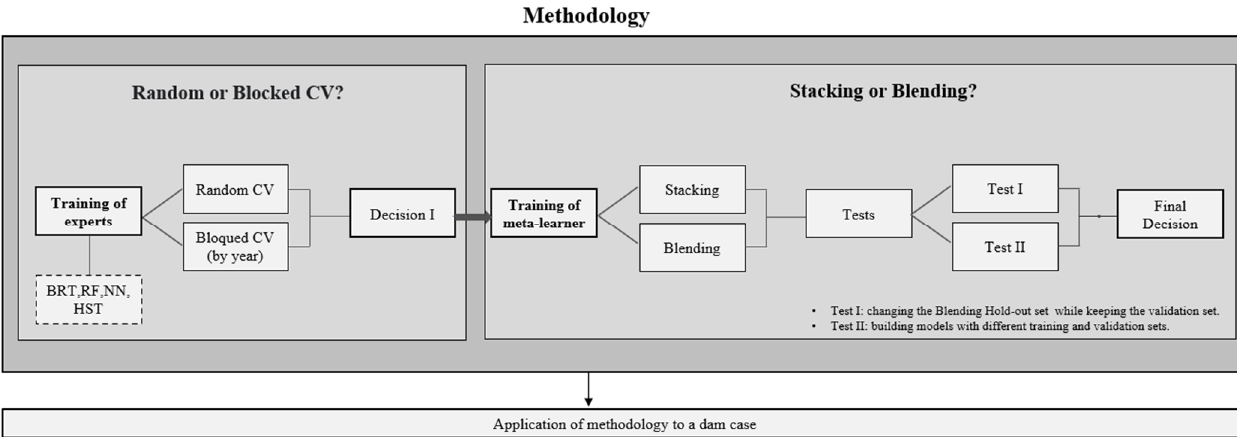
Figure 1. Summary of the methodology.